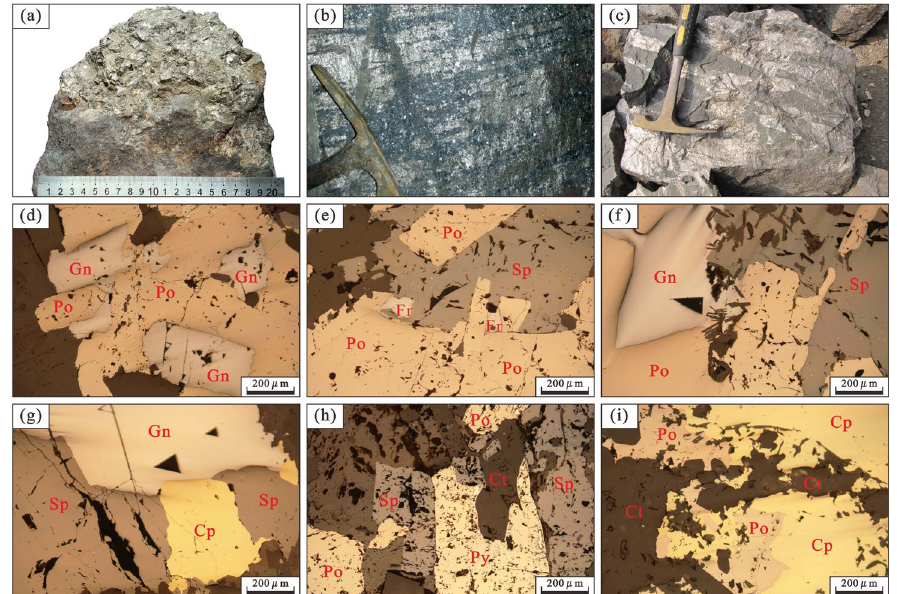
Figure 3. Photographs of the ores and their microscopic features. ( a ) Massive ore; ( b ) laminated ore; ( c ) veined ore; ( d ) galena replacing pyrrhotite; ( e ) sphalerite and freibergite replacing pyrrhotite; ( f ) galena and sphalerite replacing pyrrhotite; ( g ) chalcopyrite replacing sphalerite and galena; ( h ) sphalerite and pyrite enclosing automorphic cassiterite, with a mosaic texture; and ( i ) chalcopy- rite and pyrrhotite enclosing automorphic cassiterite, with a mosaic texture. Cp = chalcopyrite; Ct = cassiterite; Fr = freibergite; Gn = galena; Po = pyrrhotite; Py = pyrite; and Sp =